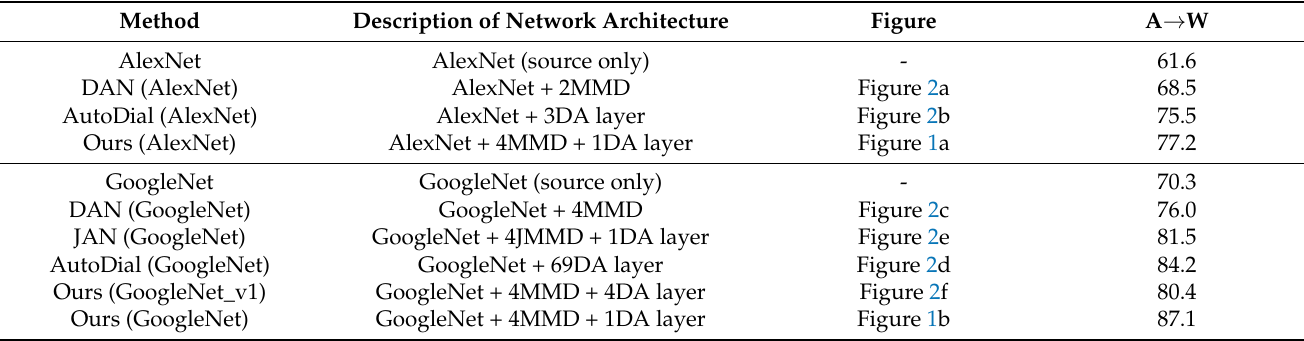
Table 5. Ablation study: a description of the network architecture and the classification accuracy achieved by each method (%) for unsupervised domain adaptation (the results on task A → W were used as an